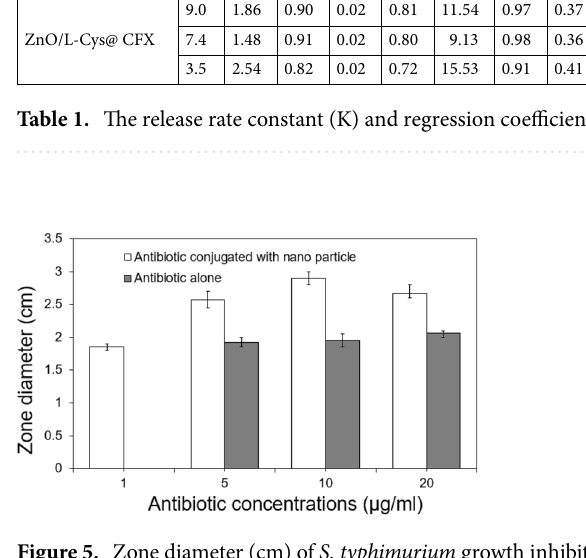
Figure 5. Zone diameter (cm) of S. typhimurium growth inhibition zone at different concentrations of CFX and CFX conjugated nanocarrier in disc diffusion method (S/N =